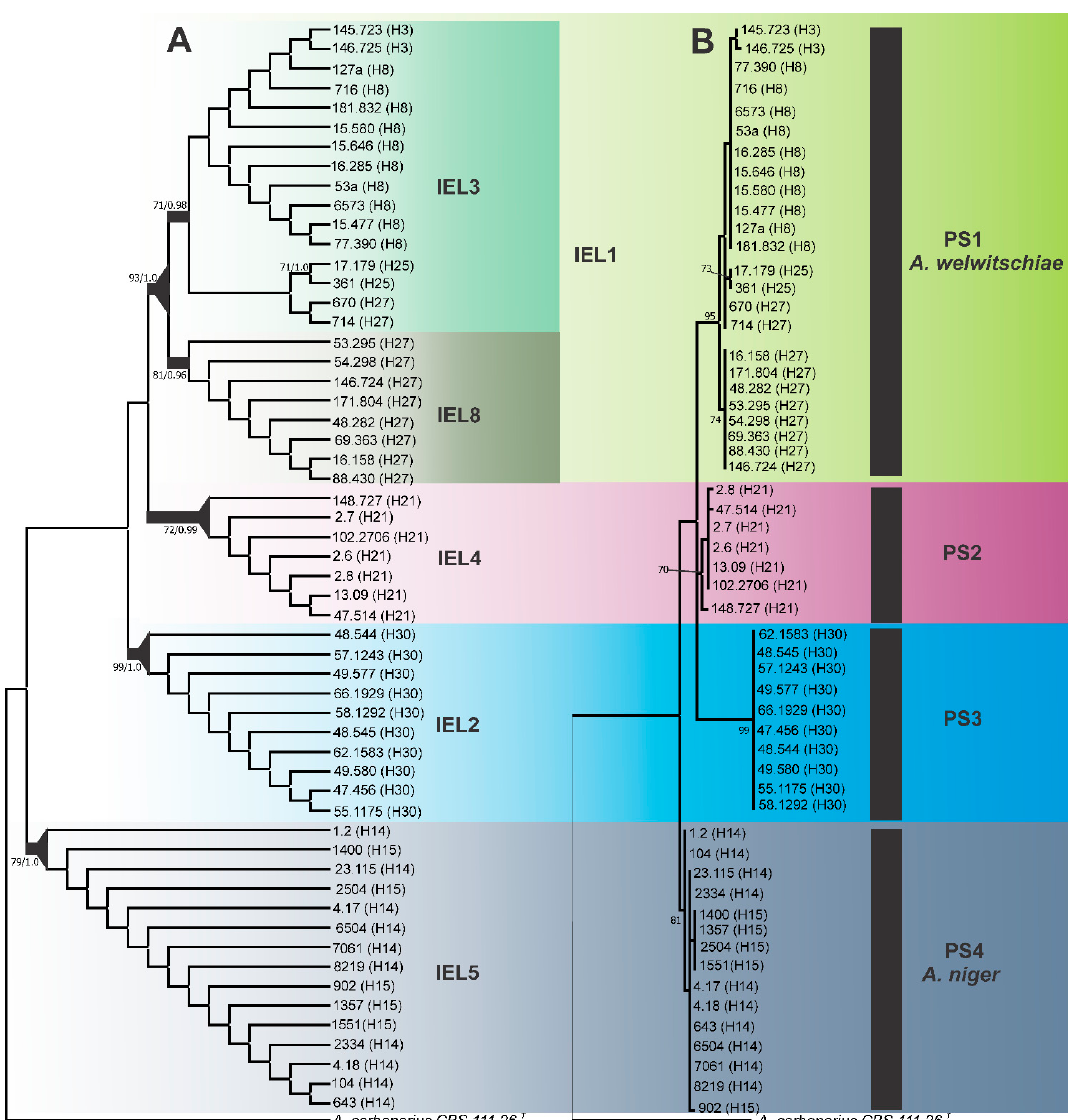
Figure 2. ( A ) Maximum Parsimony cladogram of A. niger clade species using three- locus ( CaM, BenA, and RPB2 ) phylogenies. The branches in bold indicate that these clades were considered independent evolutionary lineages. The triangles at the nodes indicate phylogenetic species based on the ranking of groups (Dettman et al. [23]). Bootstrap values (BP) and / or posterior probabilities values (PP) higher than 70% and 0.70 respectively, are shown. A. carbonarius is the outgroup. ( B ) Maximum Likelihood tree based on concatenated loci ( CaM + BenA + RPB2 ) of Aspergillus niger clade species. PS 2 = Phylogenetic species 2, PS3 = Aspergillus vinaceus sp. nov. Only bootstrap ≥ 70% are shown. Aspergillus carbonarius is the outgroup. Superscript T = Type strain.